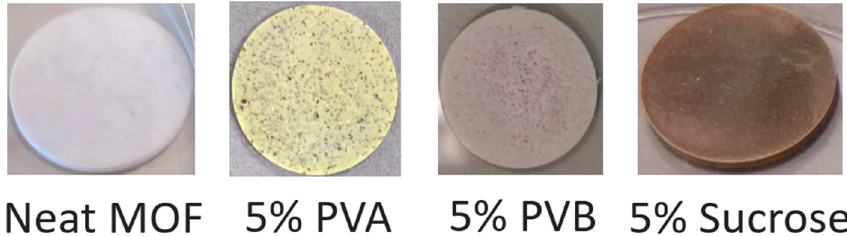
Figure 4. Photographs of representative pellets after thermal treatment at 120 °C for 2 h.